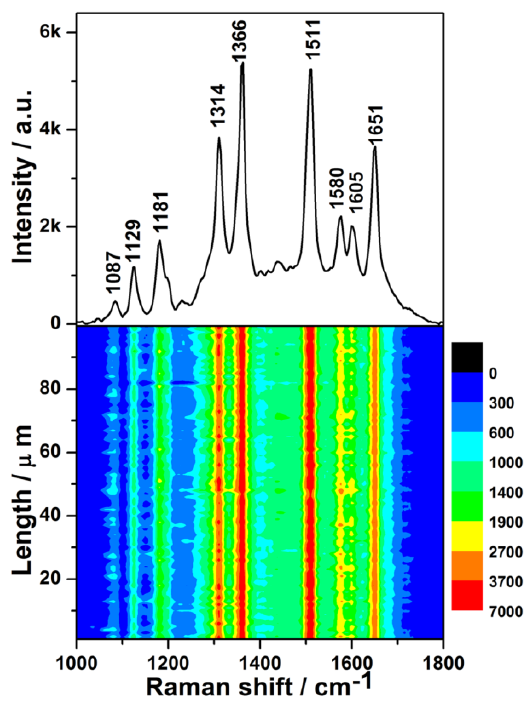
Figure 4. ( Upper ): surface-enhanced Raman scattering (SERS) spectrum of 1 × 10 − 8 M Rhodamine 6G (R6G) solution on the Ge wafer grafted with Ag–Pt nanoparticles. ( Lower ): SERS contour from line mapping of 100 spots.